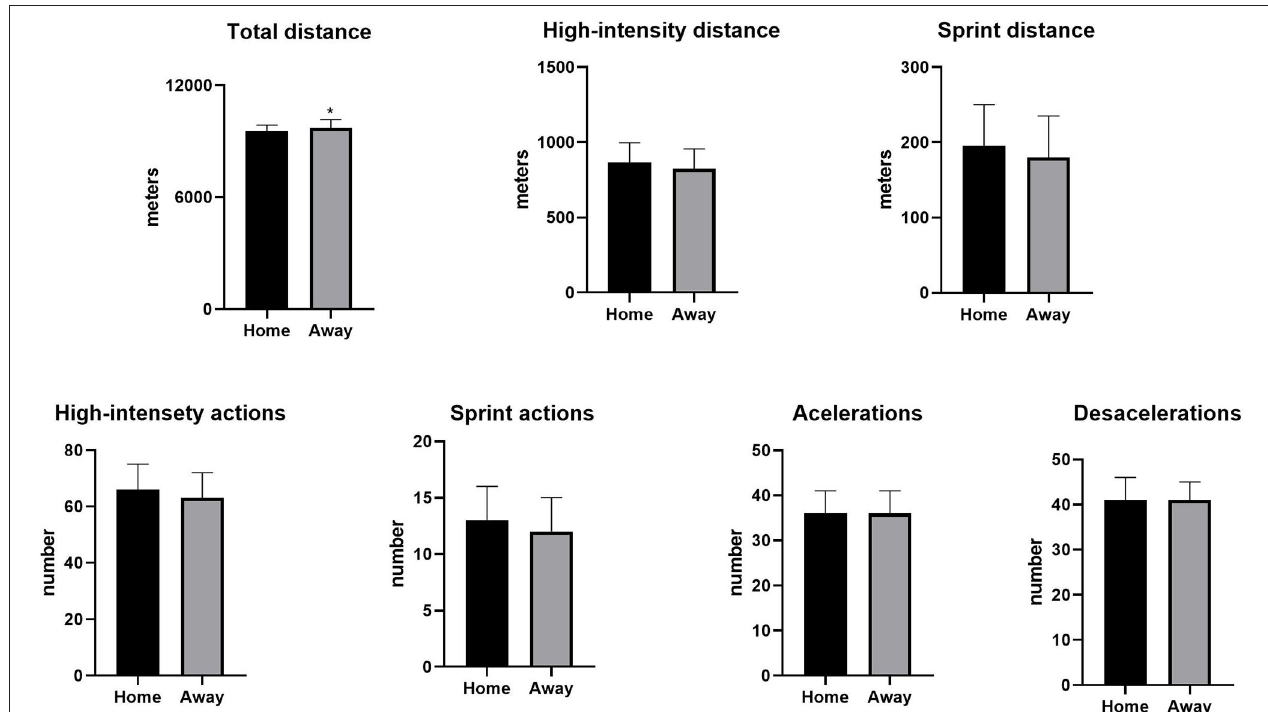
FIGURE 2 | Running performance differences according to match outcome in Brazilian elite professional soccer players. *Loss > Draw; # Loss > Win; **Draws > Loss.